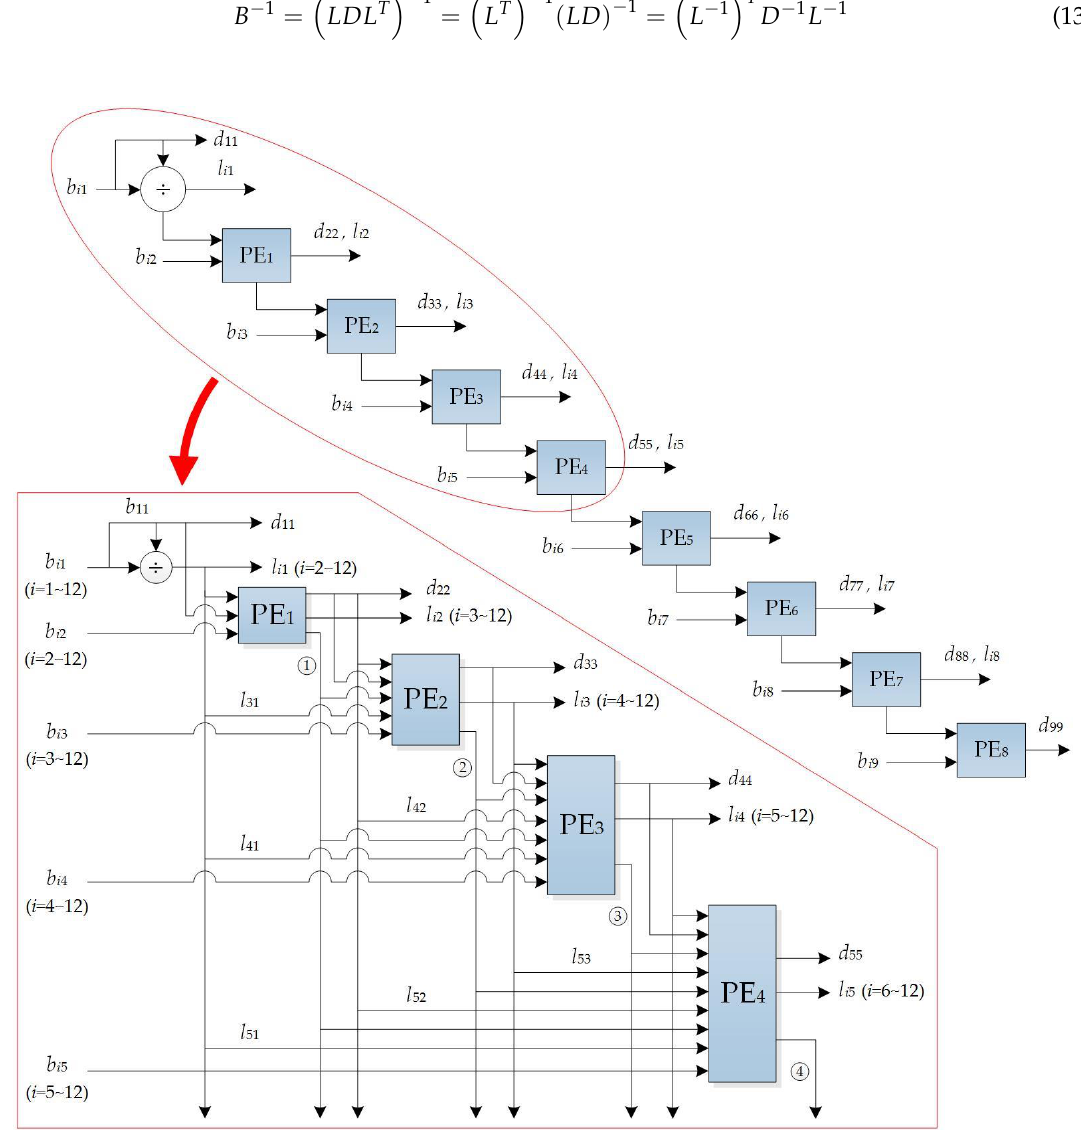
Figure 8. FPGA-based computation of B −1 through LDL T decomposition, where the dimension of B at 9 × 9 (i.e., n = 9) is taken as an example.